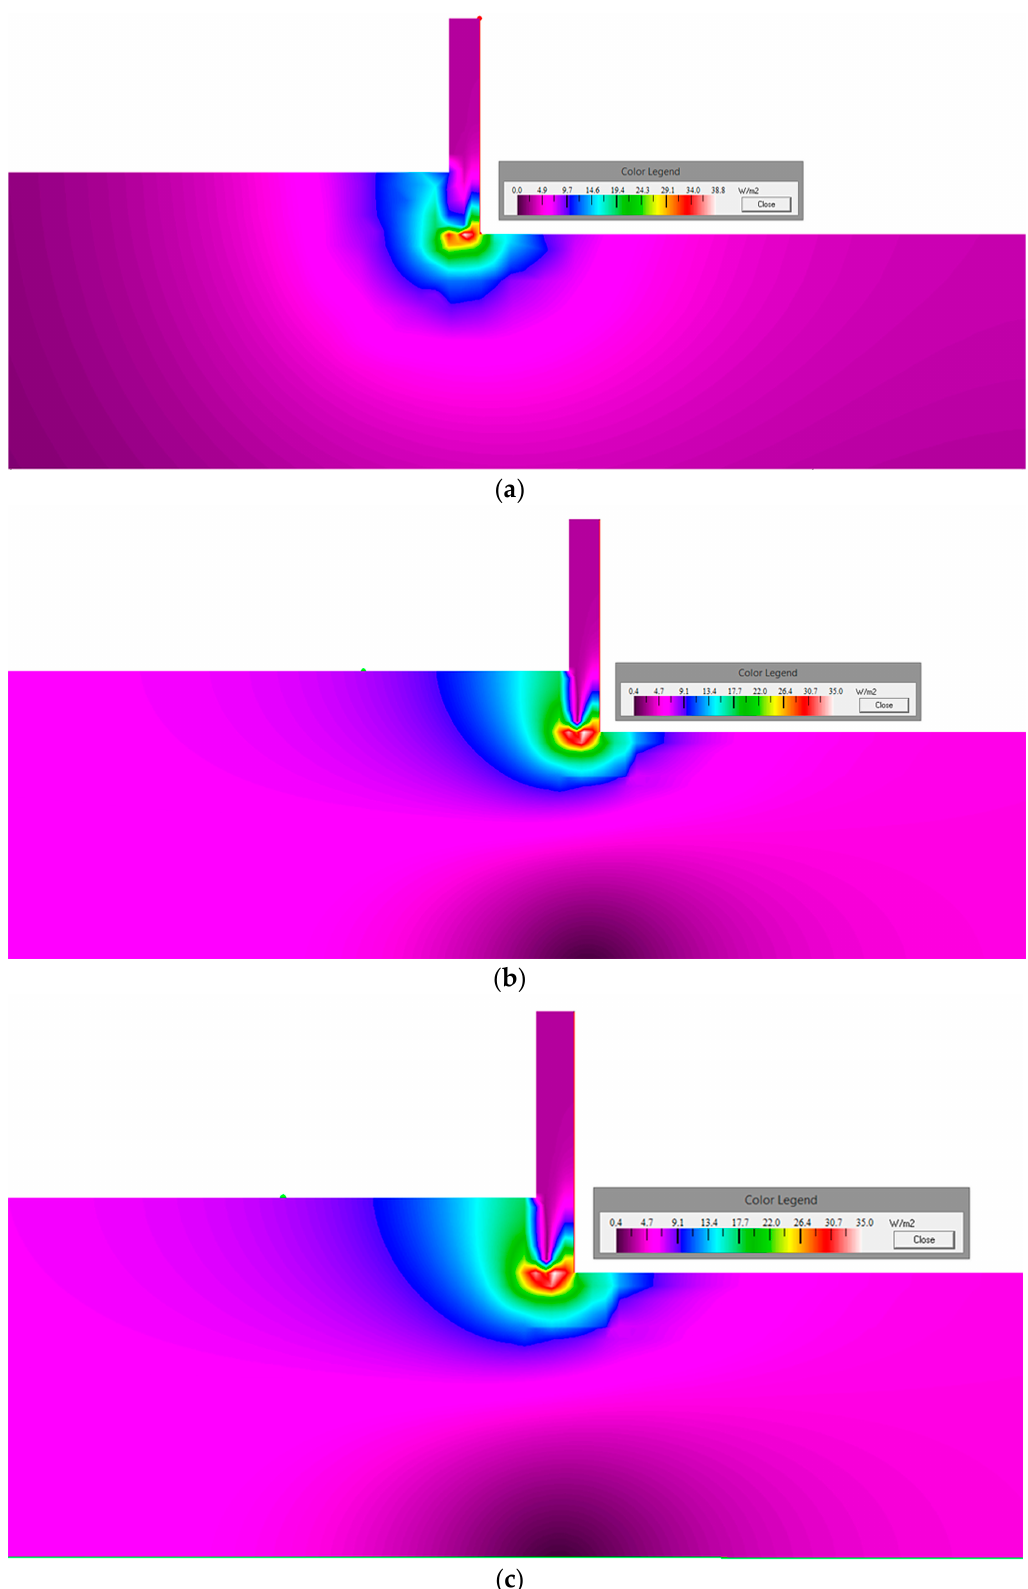
Figure 10. Heat flux density distribution: ( a ) base model W_1; ( b ) model W_2 for Profile I; ( c ) model W_3 for Profile II.